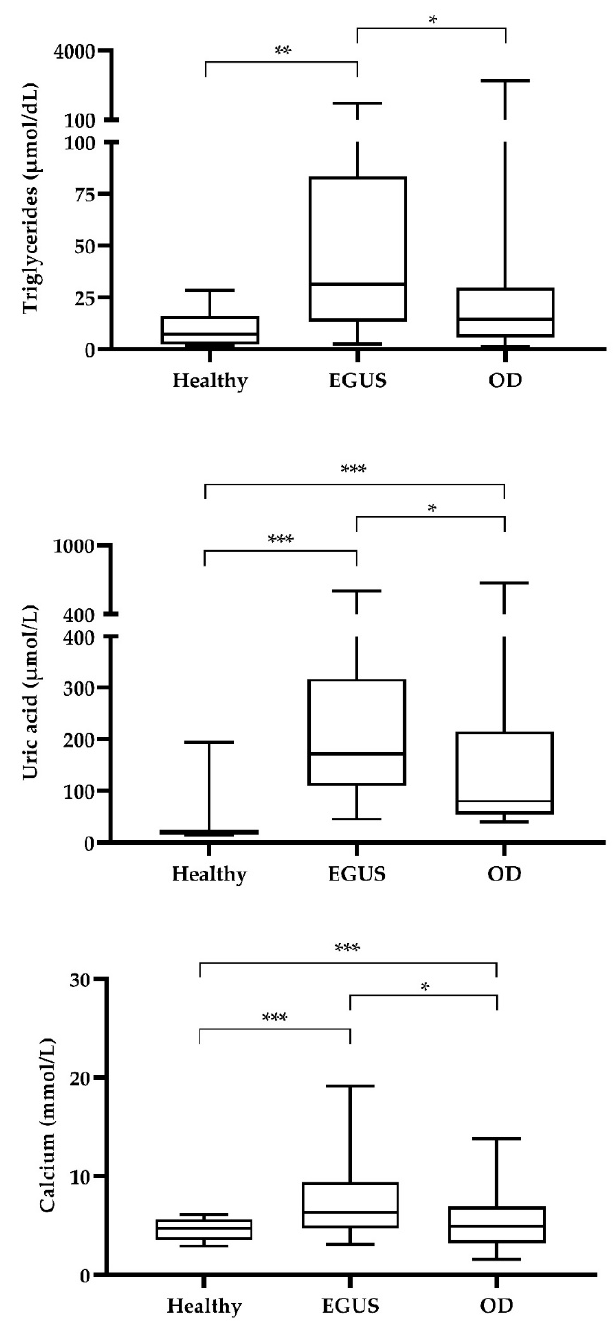
Figure 1. Results obtained of salivary triglycerides, uric acid and calcium in healthy horses (Healthy, n = 12), horses diagnosed with EGUS ( n = 110) and horses diagnosed with other gastrointestinal disorders apart from EGUS but with similar symptoms (OD, n = 25). Line shows median value, and box and whiskers show 10–90 percentiles. Statistical analysis: asterisks indicate Bonferroni post-hoc test significant results (*: p < 0.05 with H; **: p < 0.01 with H; ***: p < 0.001).